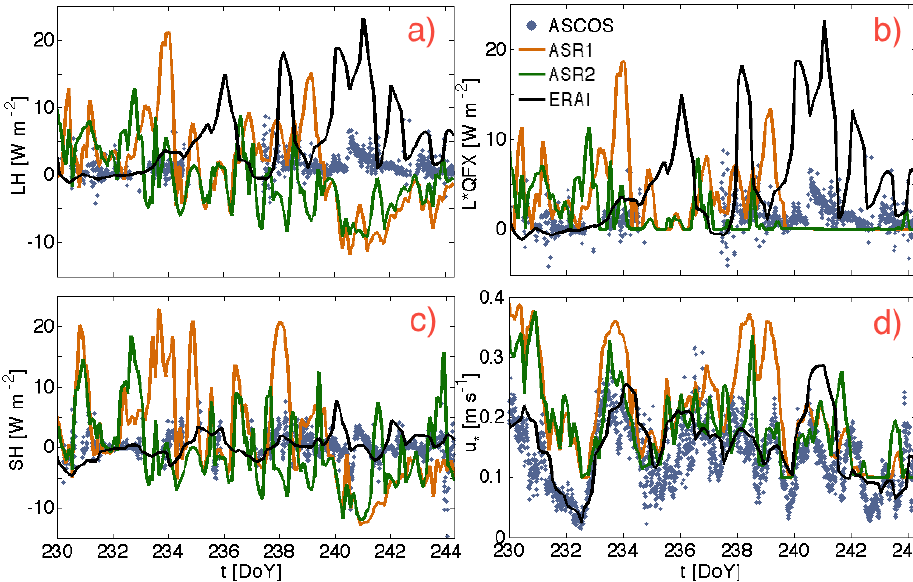
Fig. 15. Time series of the turbulent surface fluxes from the ASCOS ice drift showing (a) latent heat flux at the surface (LH); (b) moisture flux times the latent heat of vaporization at 0 ◦ C (L ∗ QFX); (c) sensible heat flux (SH) in Wm − 2 ; and (d) the friction velocity, u ∗ , in ms − 1 . The turbulent fluxes are defined positive